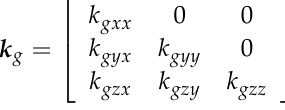
method should be used. The Kalman filter is an optimized autoregressive data processing algorithm [27]. The basic principle of the algorithm is to use the minimum mean square error as the best estimation criterion, and use the state-space model of signal and noise to introduce the relationship between state variables and observed variables by establishing state equations and observation equations model [28]. KF is a linear filter, which is only suitable for linear systems. EKF (Extended Kalman Filters) and UKF (Unscented Kalman filters) are both developed to work with nonlinear systems. As the EKF linearizes the